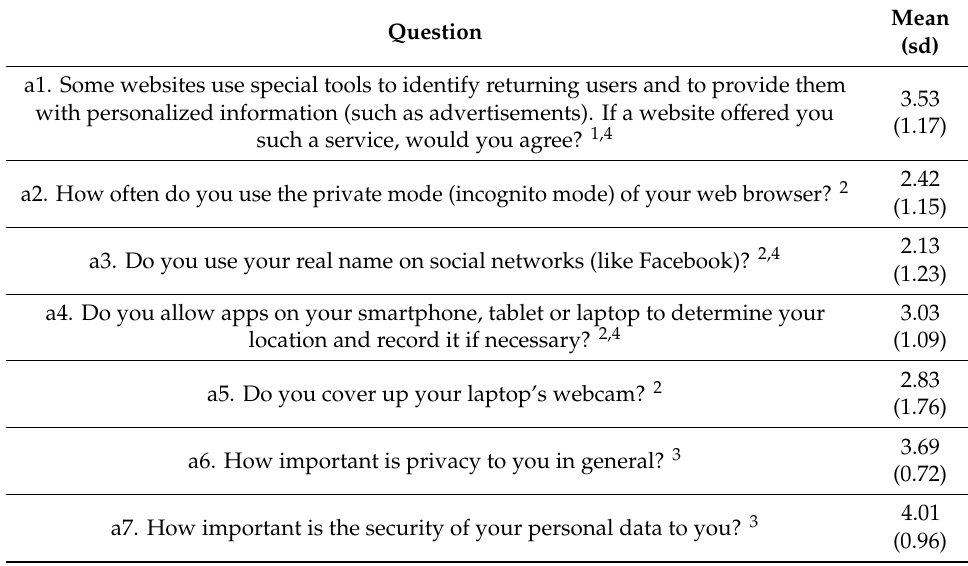
Table 1. Average scores for privacy preference indicators.